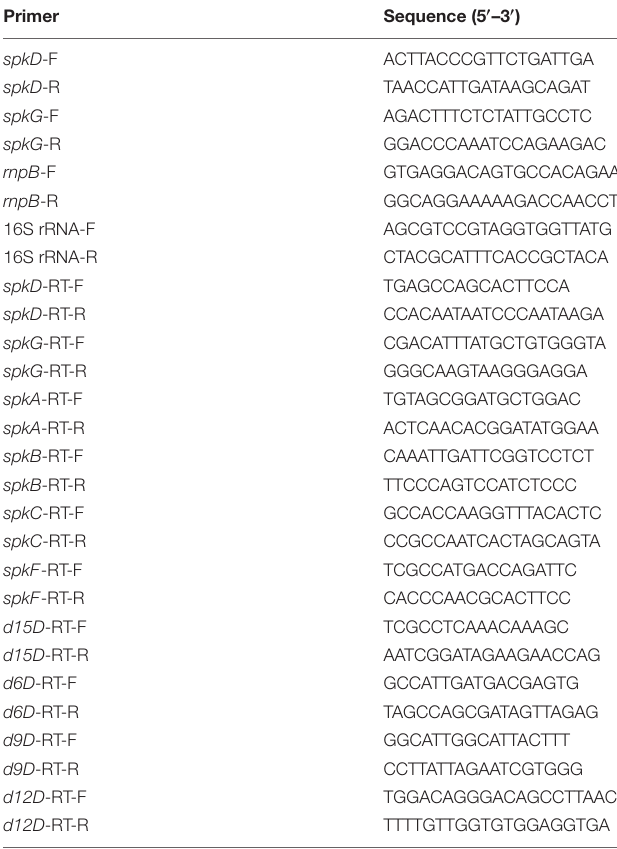
TABLE 1 | Primer sequences used in this study. Primer Sequence (5 (cid:48) –3 (cid:48) )